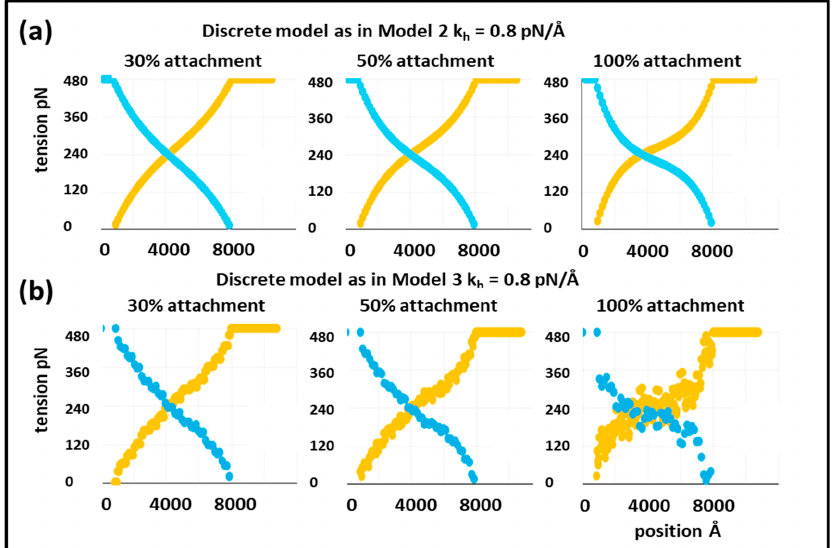
Figure A5. Tension curves along the myosin filament (blue) and actin filaments (orange) calculated from ( a ) Model 2 and ( b ) Model (3). The tension curves were calculated with 30% head attachment (first column), 50% head attachment (middle column) and 100% head attachment (third column). After applying a force of 480 pN to the last monomer in the actin filament and calculating the new monomer positions, we obtained the tension of the springs between adjacent monomers using Hooke’s law, and we plotted these values as a function of spring’s position along the half-sarcomere. The position 0 corresponds to the centre of the M-band. In all cases, k m = 720 pN / Å for the myosin filament, k a = 2280 pN / Å for the actin filament and k h = 0.8 pN / Å for the heads. Note that the analysis of Ford et al. [4] went part way towards this in their Figure 4 (lower